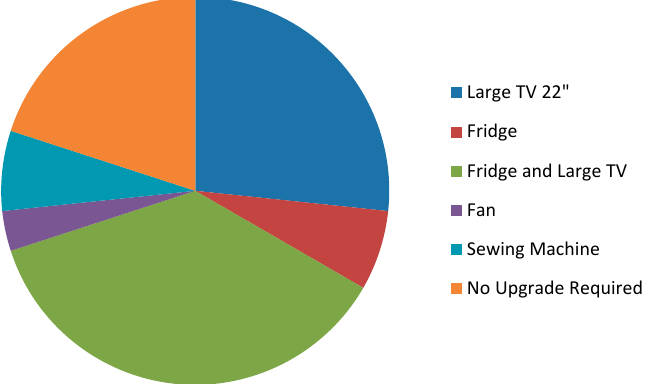
Figure 7. Aspirations to add larger appliances than currently available